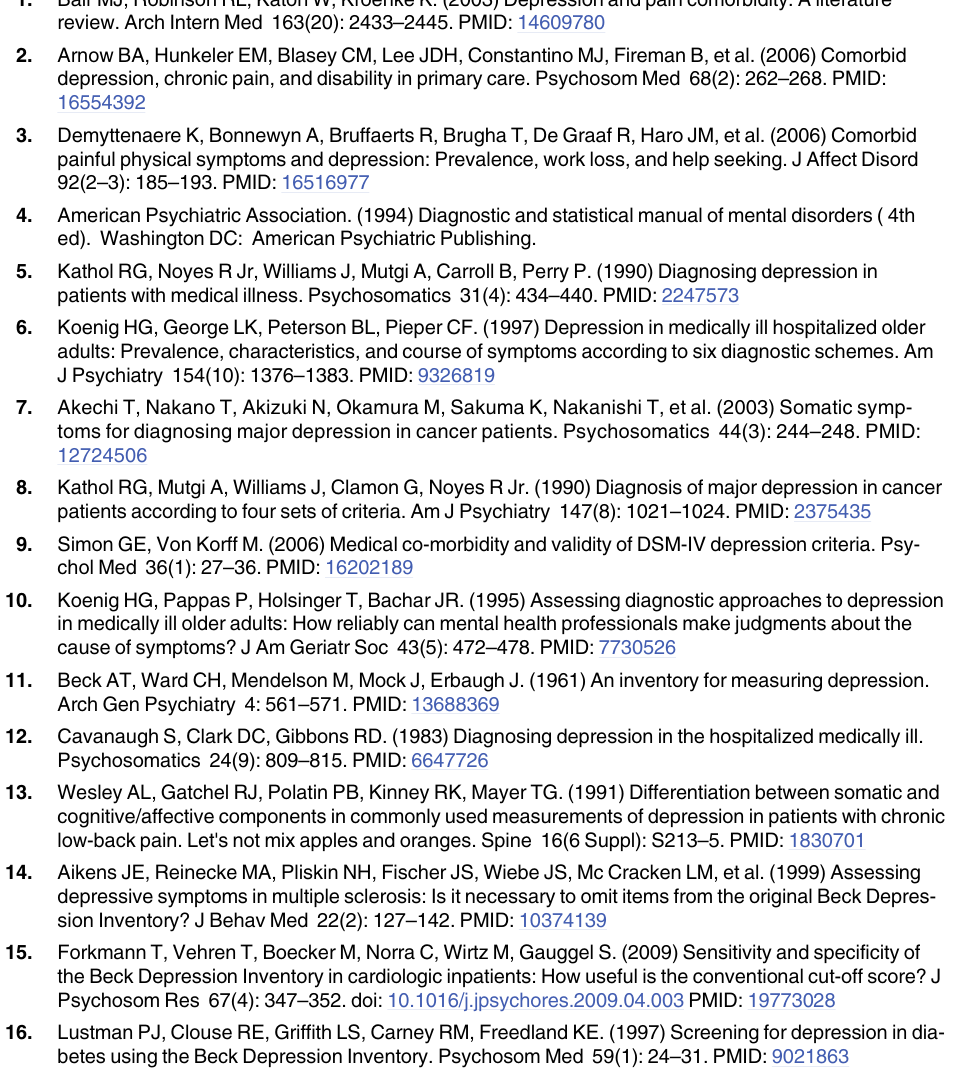
S1 Table. Comparison of BDI items in patients with and without MDD.